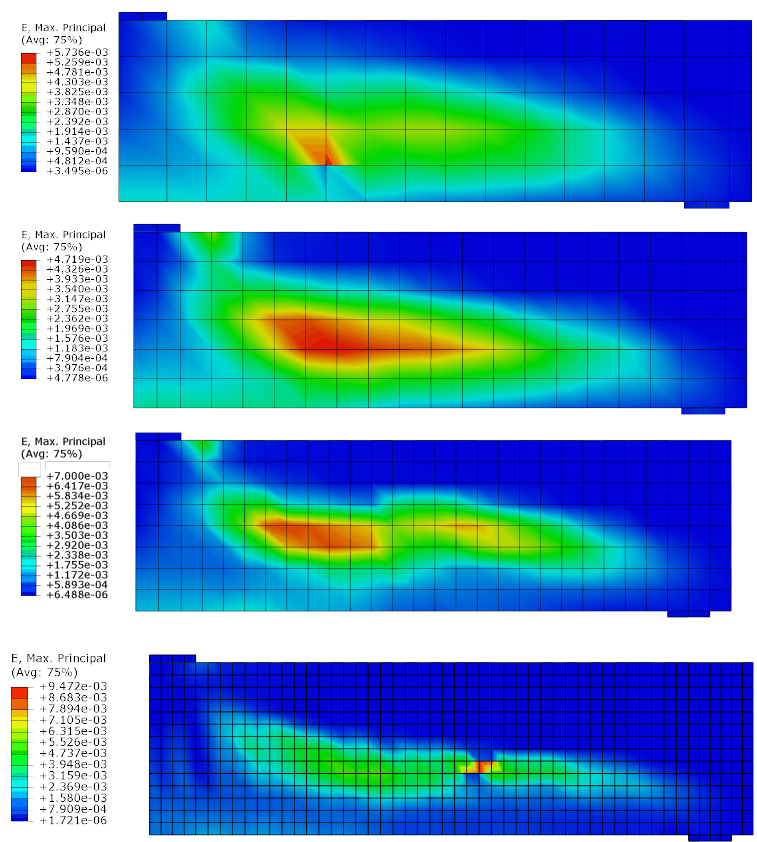
Figure 25. OA-1 beam failure in shear—maps of maximum principal